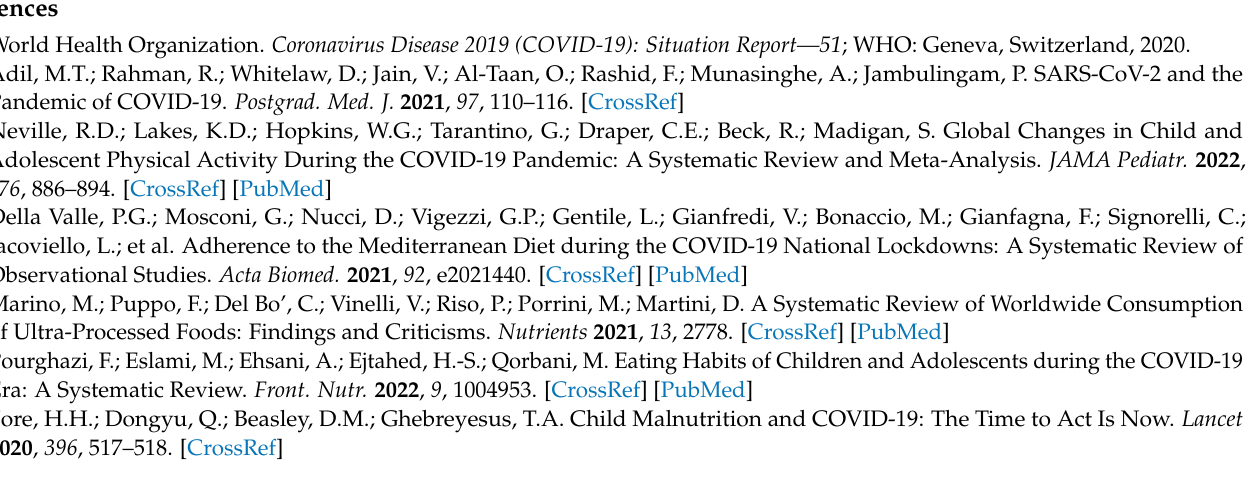
Table S1. Mediterranean Diet Quality Index for Children and Teenagers. Table S2. Association be- tween Mediterranean Diet adherence and problems in different dimensions of health-related quality of life by sex or age